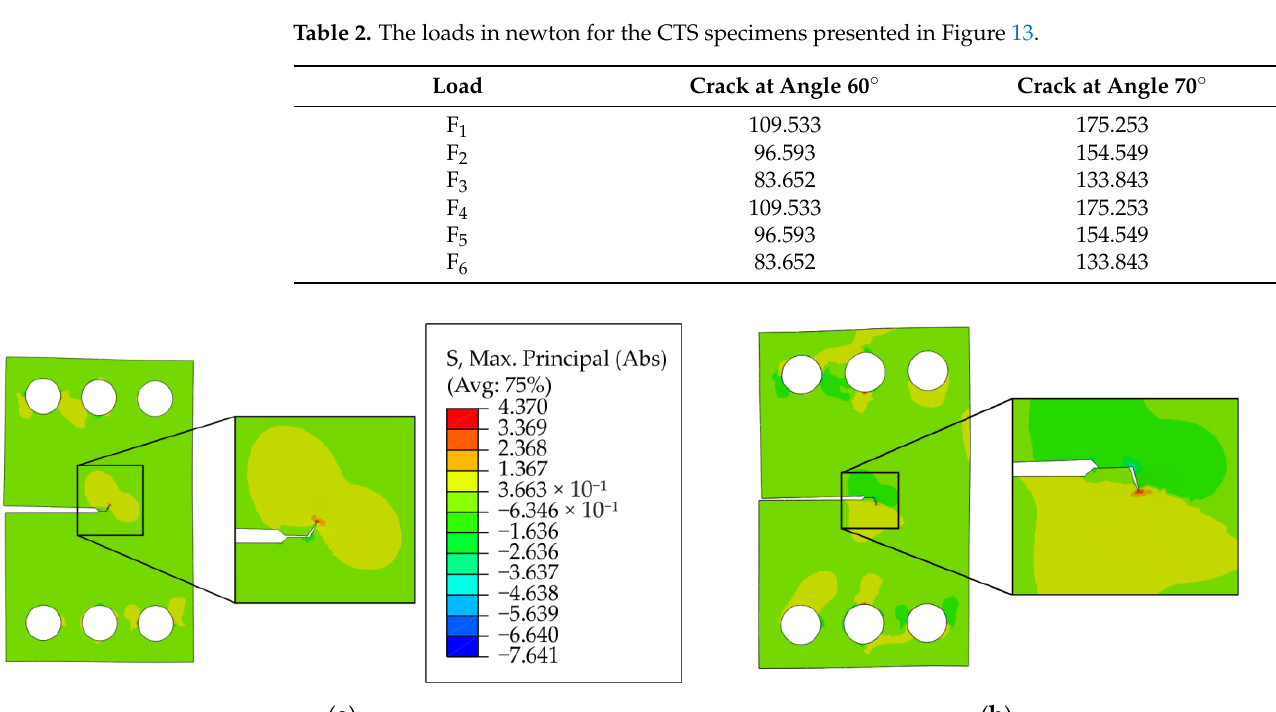
( b ) Figure 15. Stress intensity factors calculated by Adapcrack3D for CTS specimens and the difference between the results: ( a ). Stress intensity factors, K I , along the crack fronts for cracks deflected up- wards and downwards; ( b ) Difference between the values in Figure 15a along the crack front. Another simulation carried out in Adapcrack3D considers rolling contact fatigue. In this simulation, the behavior of a crack in a rail is simulated when a wheel rolls over it. The rolling procedure and the finite element model are shown in Figure 16. The wheel starts on the left side of the crack and rolls over it to create a normal force and a traction force. The rolling direction and the traction force are shown in Figure 16a. The surface crack is oriented at an angle of 30°, and the models are created with contact definitions between the wheel and rail as well as between the crack surfaces. A detail from the meshed model prepared for the simulation is displayed in Figure 16b.